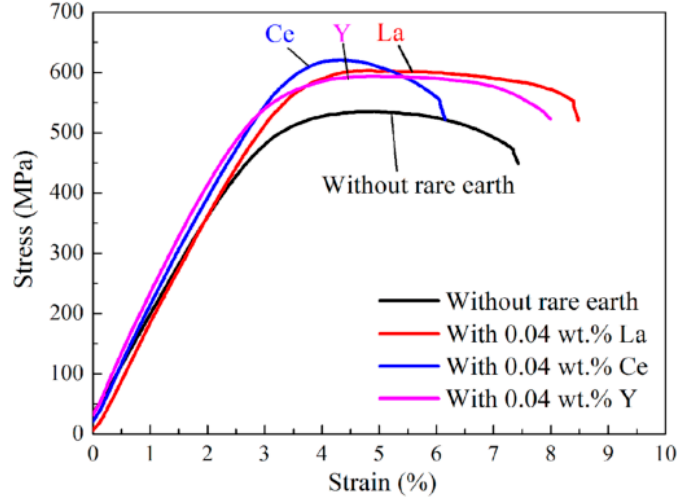
Figure 13. Effects of different rare earths on the tensile strength of (TiB 2p + TiB w )/Cu composites [36]. Reprinted/adapted with permission from Ref. [36]. Copyright year 2022, Elsevier.